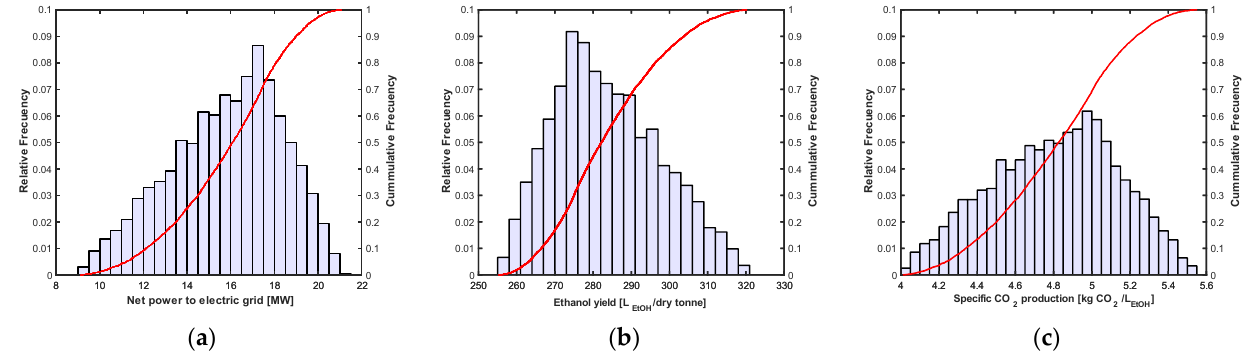
Figure 3. Uncertainty analysis results for the net power exported to the electrical grid ( a ), bioethanol yield ( b ), and specific CO 2 production ( c ) using Monte Carlo simulation with 5000 scenarios. Red lines represent the cumulative frequency, while bars represent the relative frequency.